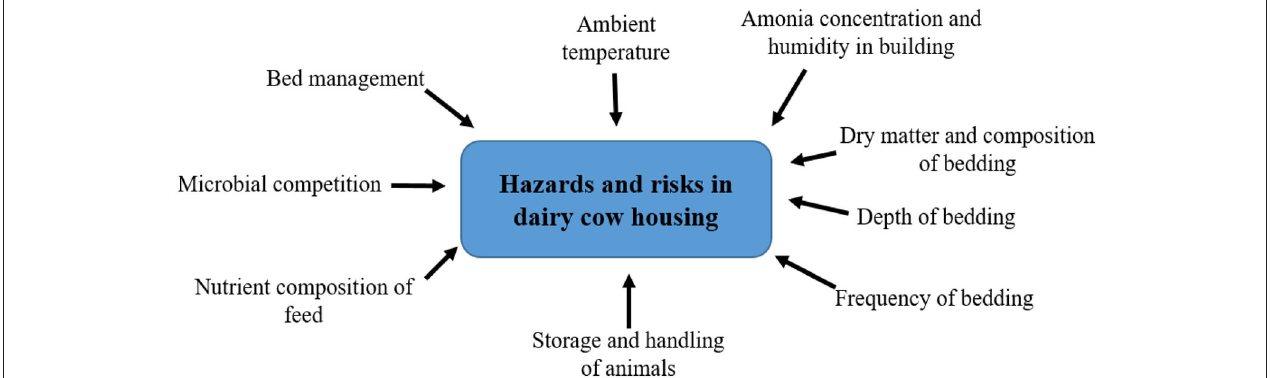
FIGURE 5 | Factors affecting hazards and risks associated with bedding materials in dairy cow housing. Source: Adapted from Bradley et al. (82).